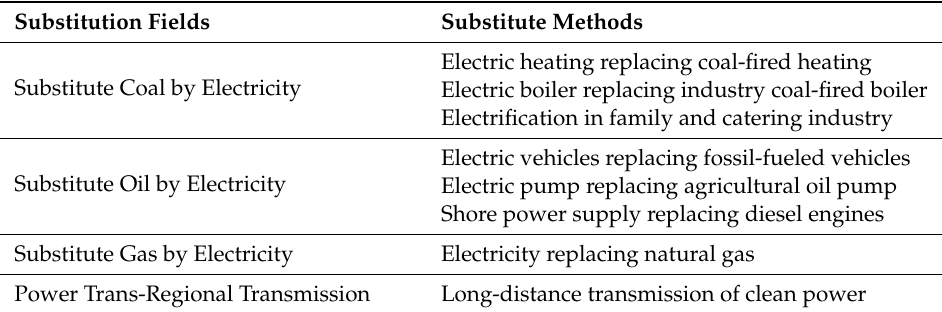
Table 1. Electric power substitution